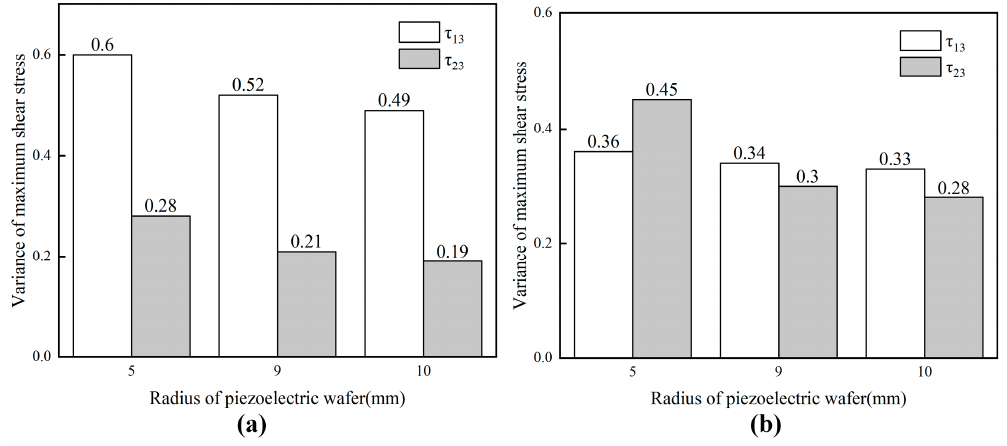
Figure 14. Variance of maximum shear stress along Y axis ( a ) and X axis ( b ).